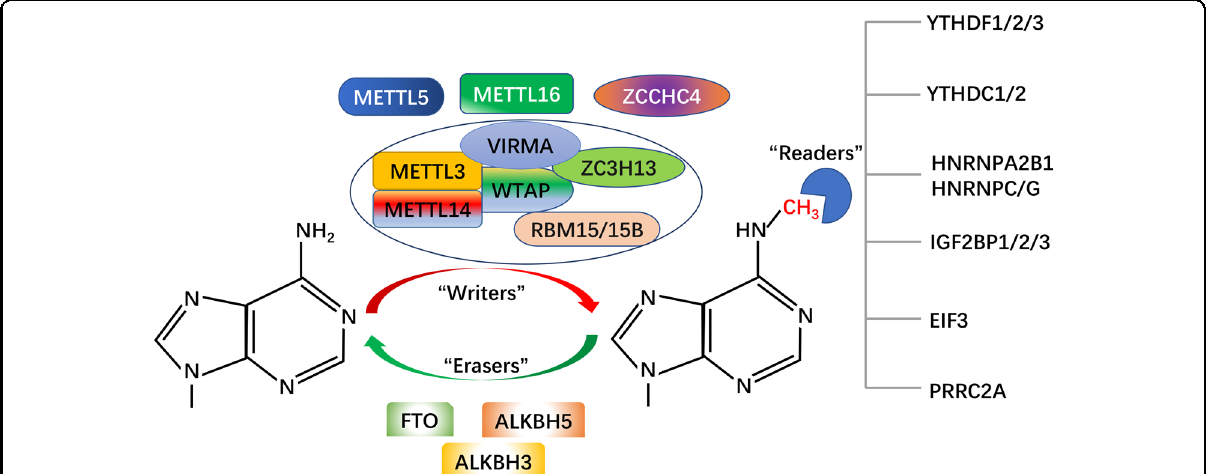
Fig. 1 Dynamic reversible process and molecular composition of m6A. m6A modi fi cations are catalyzed by m6A writers, erasers, and readers. The sixth N position of adenylate (A) can be methylated by m6A writers to form N6-methyladenosine (m6A). Writers include METTL3, METTL14, WTAP, RBM15/15B, VIRMA, and ZC3H13. METTL5, METTL16, and ZCCHC4 are independent m6A methyltransferases. Erasers are proteins with demethylase activity, and include FTO, ALKBH5, and ALKBH3. Readers are proteins that perform a biological function by recognizing m6A modi fi cations, and include YTH family, HNRNP family, EIF3, IGF2BPs, and